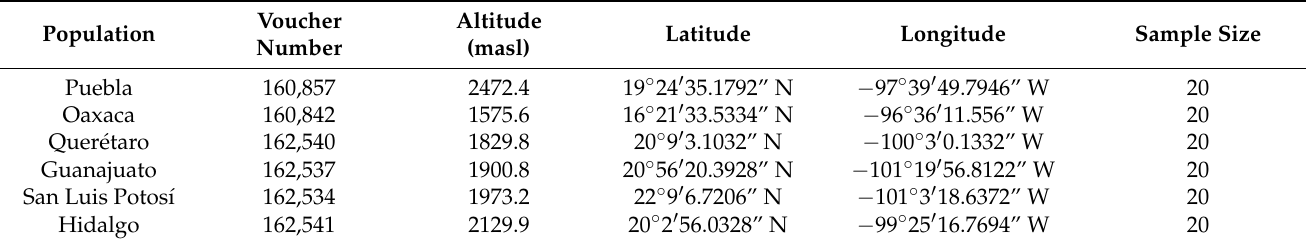
Table 5. Location and reference vouchers of samples from Brickellia veronicifolia.